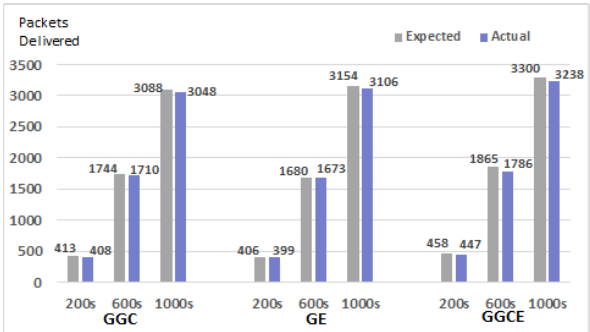
Figure 6. Multi-greedy methods PDR performances, expected versus